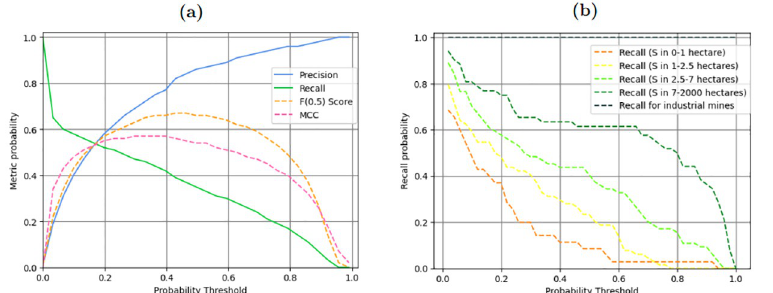
Fig 3. Main performance metrics computed on the test set . (a) Overall performance metrics (Precision, Recall, F(0.5) score and MCC) depending on the probability threshold value. (b) Recall metric along ASM size classification depending on the probability threshold